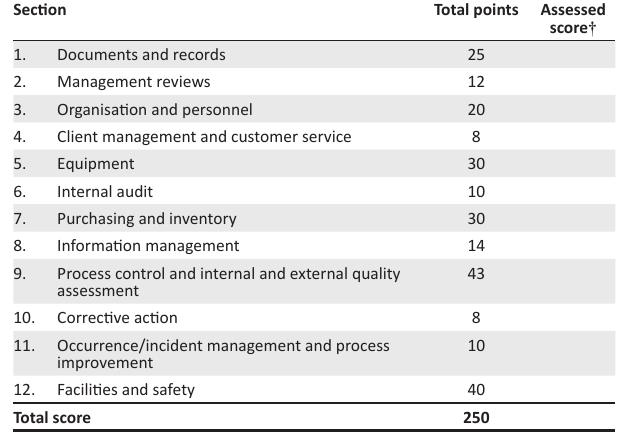
TABLE 4a: Summary of WHO AFRO SLIPTA checklist that covers the 12 Quality System Essentials and the weighted marks of each section out of the 250 total points.